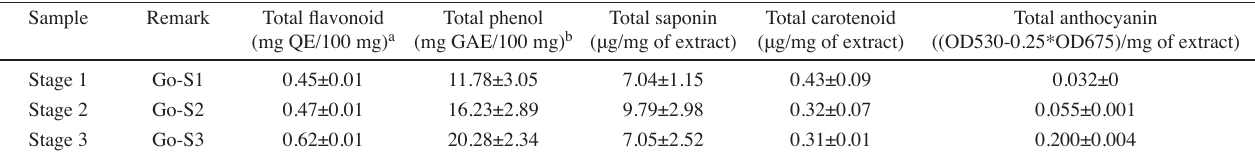
Tab. 1: The effect of various maturity stages of ginseng berry on phytochemical contents. Sample